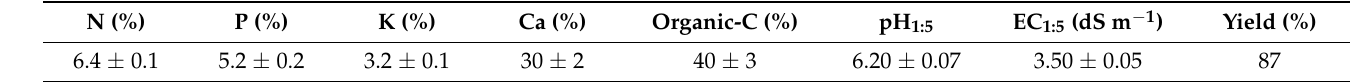
Table 1. Chemical characterization of shrimp waste-derived biochar.